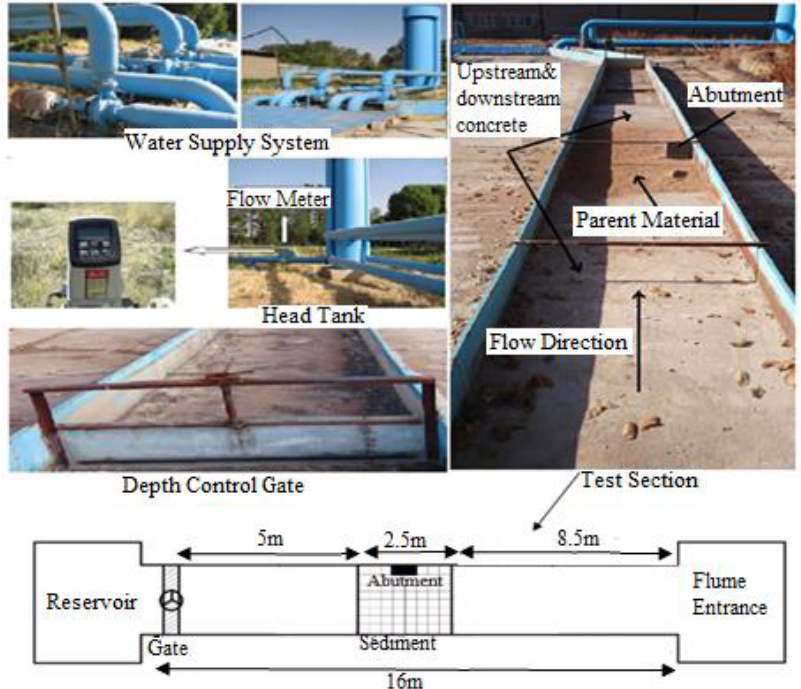
Figure 1. The scheme of test section, instrument and plan view of sediment recess.